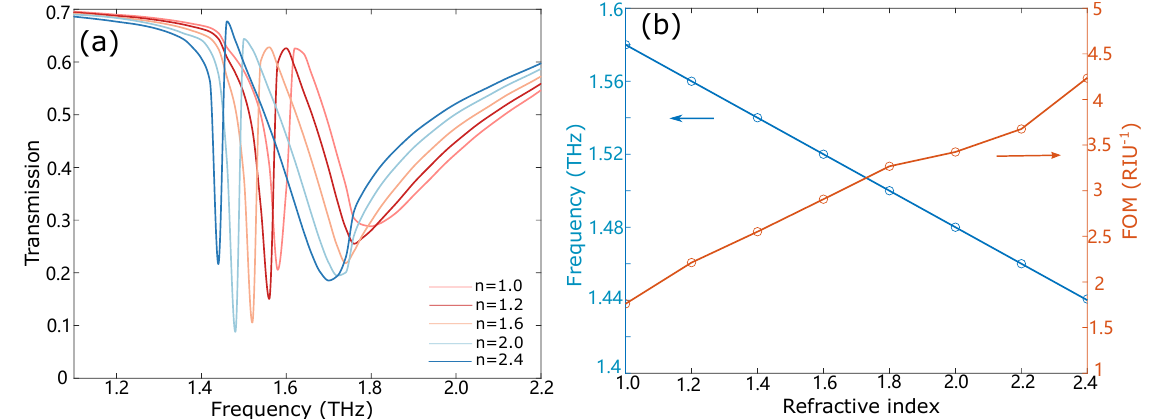
Figure 5. ( a ) Transmission spectra of the metal–graphene metamaterial with different refractive indexes of analyte. The resonance frequency shifts from 1.58 THz to 1.44 Thz with the refractive index of analyte changes from 1 to 2.4. ( b ) Resonance frequency and FOM as a function of the refractive index of analyte. The resonance frequency linearly depends on the refractive index. The maximum FOM value is 4.24 RIU − 1 when the refractive index of analyte is 2.4.